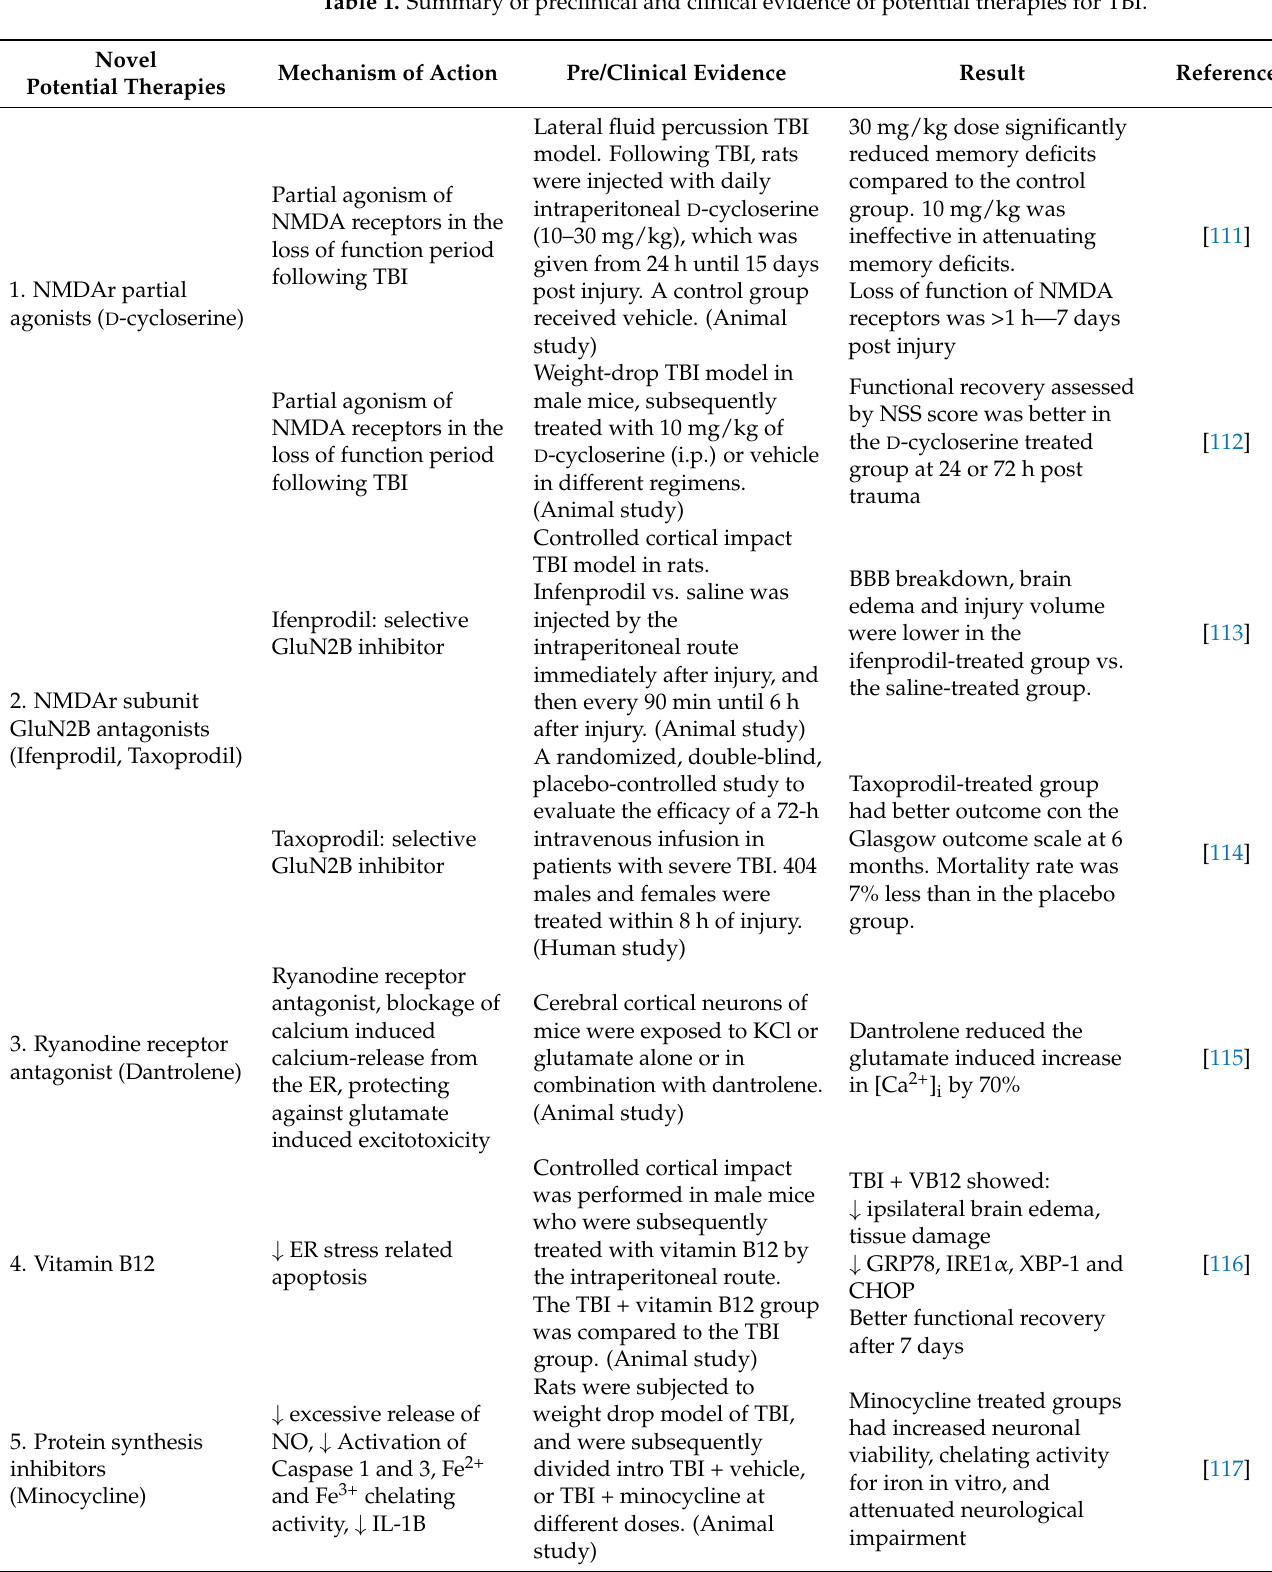
Table 1. Summary of preclinical and clinical evidence of potential therapies for